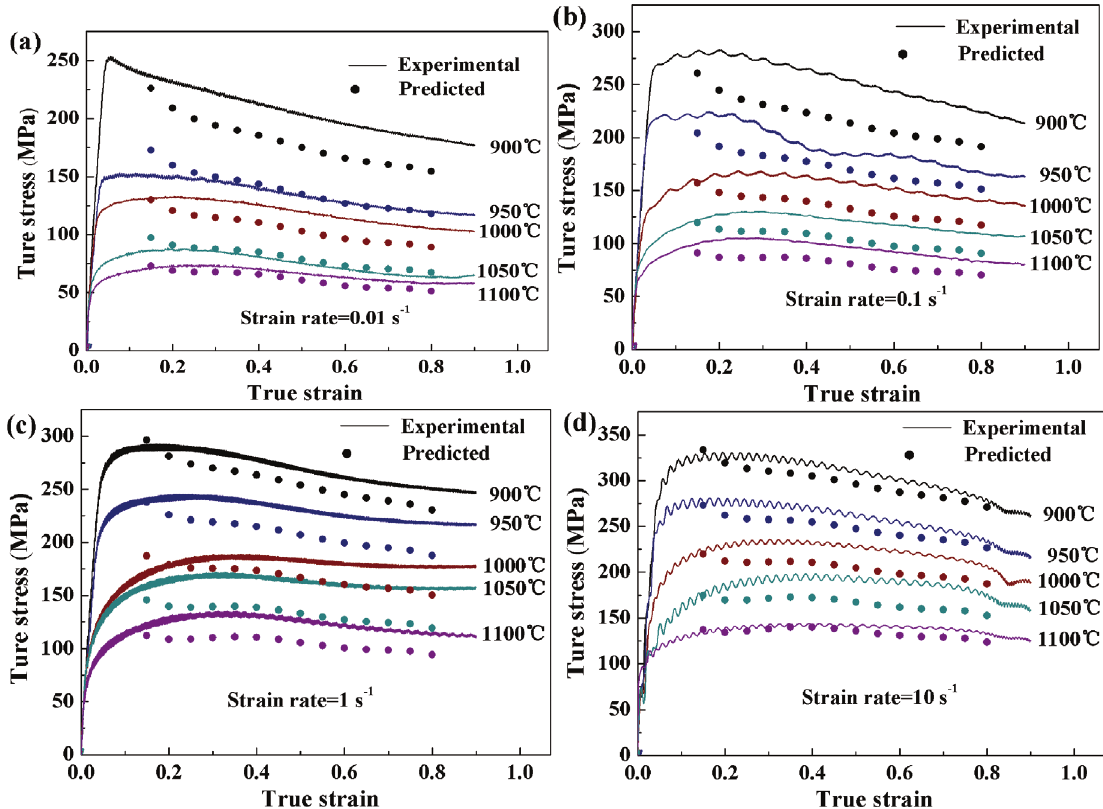
Fig. 6: Comparison between the experiment and predicted flow stress (considering the compensation of strain) at strain rate of: (a) 0.01 s − 1